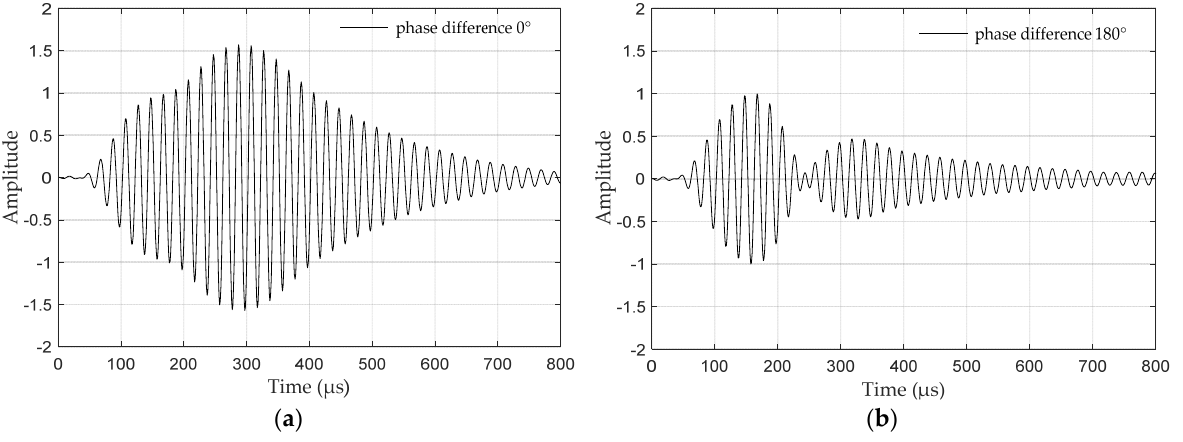
Figure 4. Two typical eLoran received-signal waveforms: ( a ) composite wave with a phase difference of 0°; ( b ) composite wave with a phase difference of 180°.